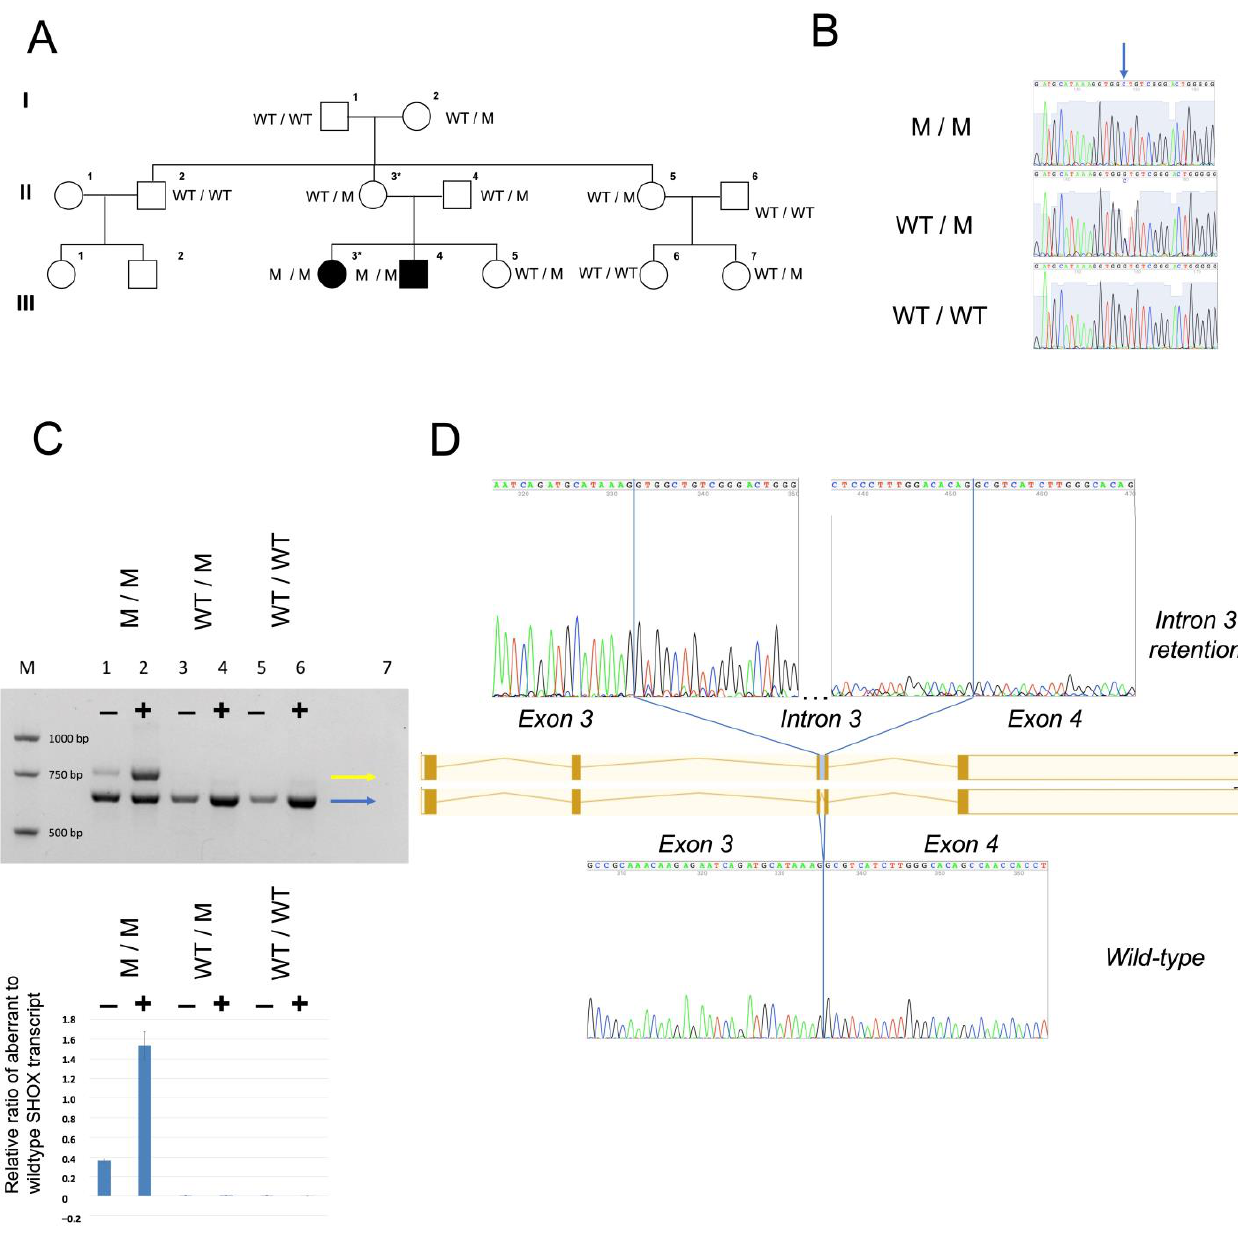
Figure 2. Pedigree, SHOX c.544+5G>C variant detection and consequences on the transcript level. ( A ) Simplified pedigree and segregation of the SHOX variant. ( B ) Sequence chromatograms to demonstrate the novel SHOX variant (arrow). ( C ) Genotype-based transcript analysis in cDNA shows that the homozygous SHOX c.544+5G>C variant leads to production of both wild-type and an aberrant transcript, which retains intron 3 (( C ) upper panel). The abnormal transcript undergoes NMD as demonstrated by RT-PCRs in cDNA obtained from fibroblasts with (+) and without (−) NMD inhibition with puromycin. M/M, M/WT, WT/WT represent homozygous mutant, heterozy- gous mutant and wild-type genotypes, M denotes a molecular size marker, lane 7 No template con- trol. In M/M, a ratio of aberrant SHOX transcript vs. wild-type transcript of 1.54 in (+) puromycin- treated patient cells (+), and of 0.36 in non-treated (-) cells was found, assessed by allele-specific qPCRs; the relative ratio of aberrant to wild-type SHOX transcript is shown (means and standard deviations of four technical replicates) (( C ) lower panel)). Sanger sequencing reveals wild-type splic- ing of all SHOX exons of the RT-PCR product common to patient, parent and control (blue arrow) and reveals retention of intron 3 in the aberrant fragment seen in the patient only (yellow arrow)( D ).